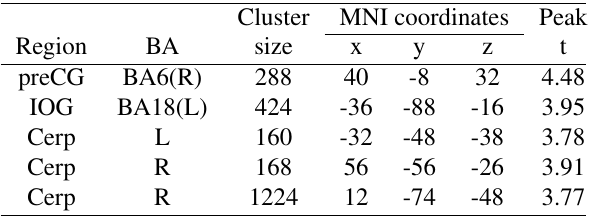
Table 1. Brain regions showing reduced connectivity in patients with early-onset schizophrenia relative to healthy controls in right medial frontal gyrus maps